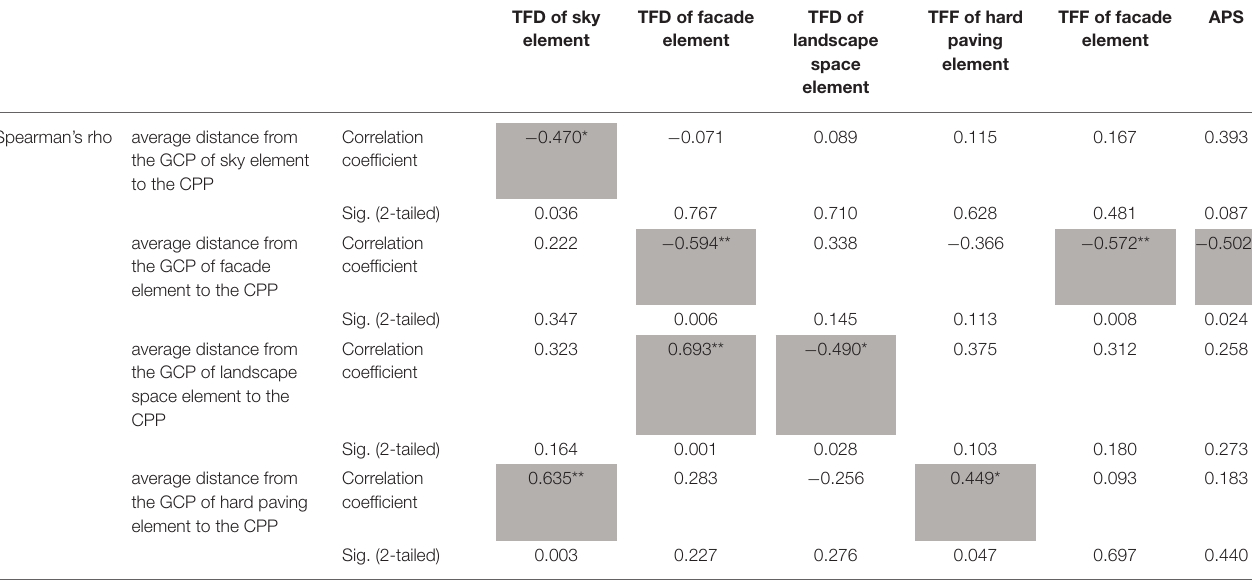
TABLE 9 | Correlations coefficient between the average distance from the GCP of each space elements to the CPP and EMM.